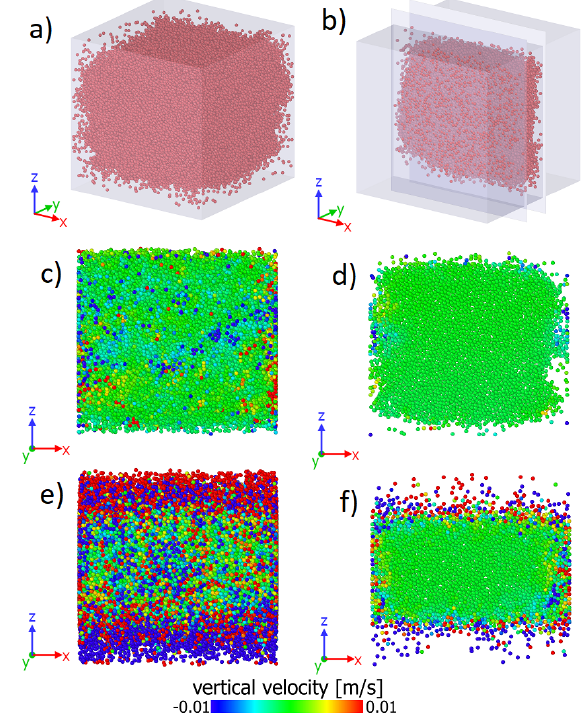
Figure 4. Simulation results of case 1 using a coe ffi cient of resti- tution of 0.1 and 0.9. In a) is depicted the full simulation box and the respective slice through its middle plane is shown in b). In c) is the full case using a coe ffi cient of restitution of 0.1, and in d) its slice taken from the full case. In e) is the full case using a coe ffi cient of restitution of 0.9, and in f) is the corresponding slice taken from the full case. In a) and b) the view is in perspec- tive, while the other images are in front view. See the coordinate tripod for reference.